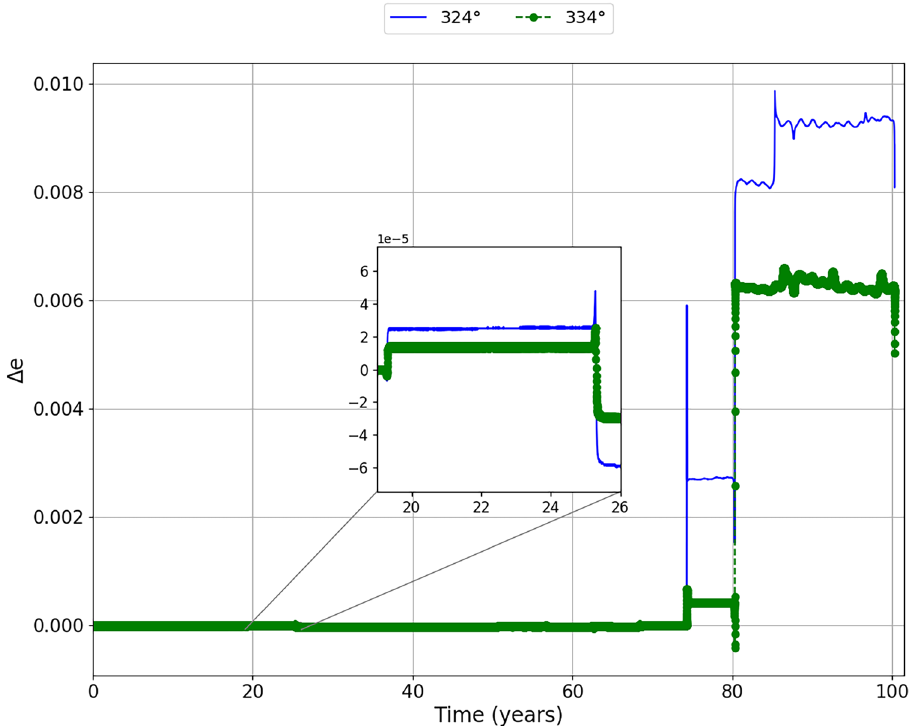
Figure 10. Difference between eccentricity with and without the impulse over time ( (cid:31) e) when the impulse is applied at the mean anomalies of 324° (blue line) and 334° (green line). We zoomed in on the region corresponding to the second largest close encounter to better visualize the variations in the eccentricity difference of the